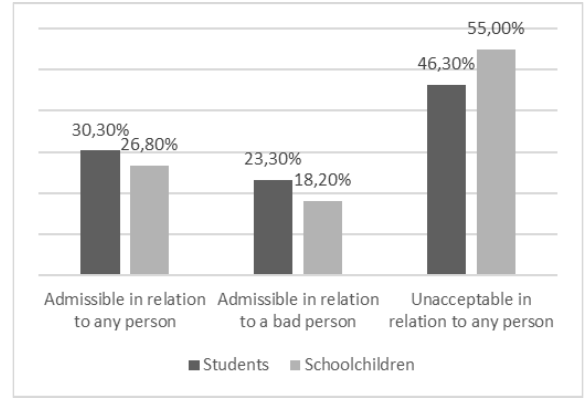
Figure 7. Attitude towards trolling